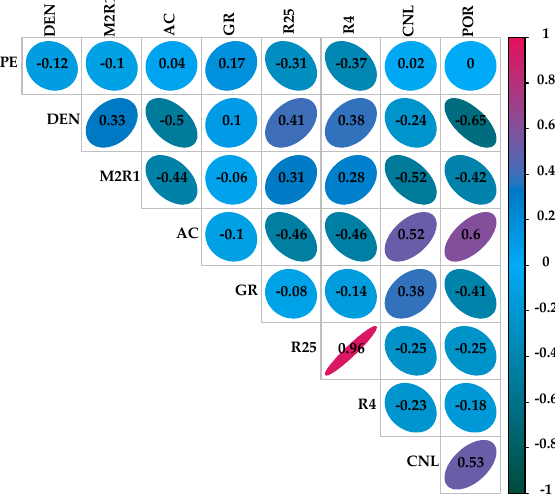
Figure 4. Correlation between parameters based on Pearson algorithm.